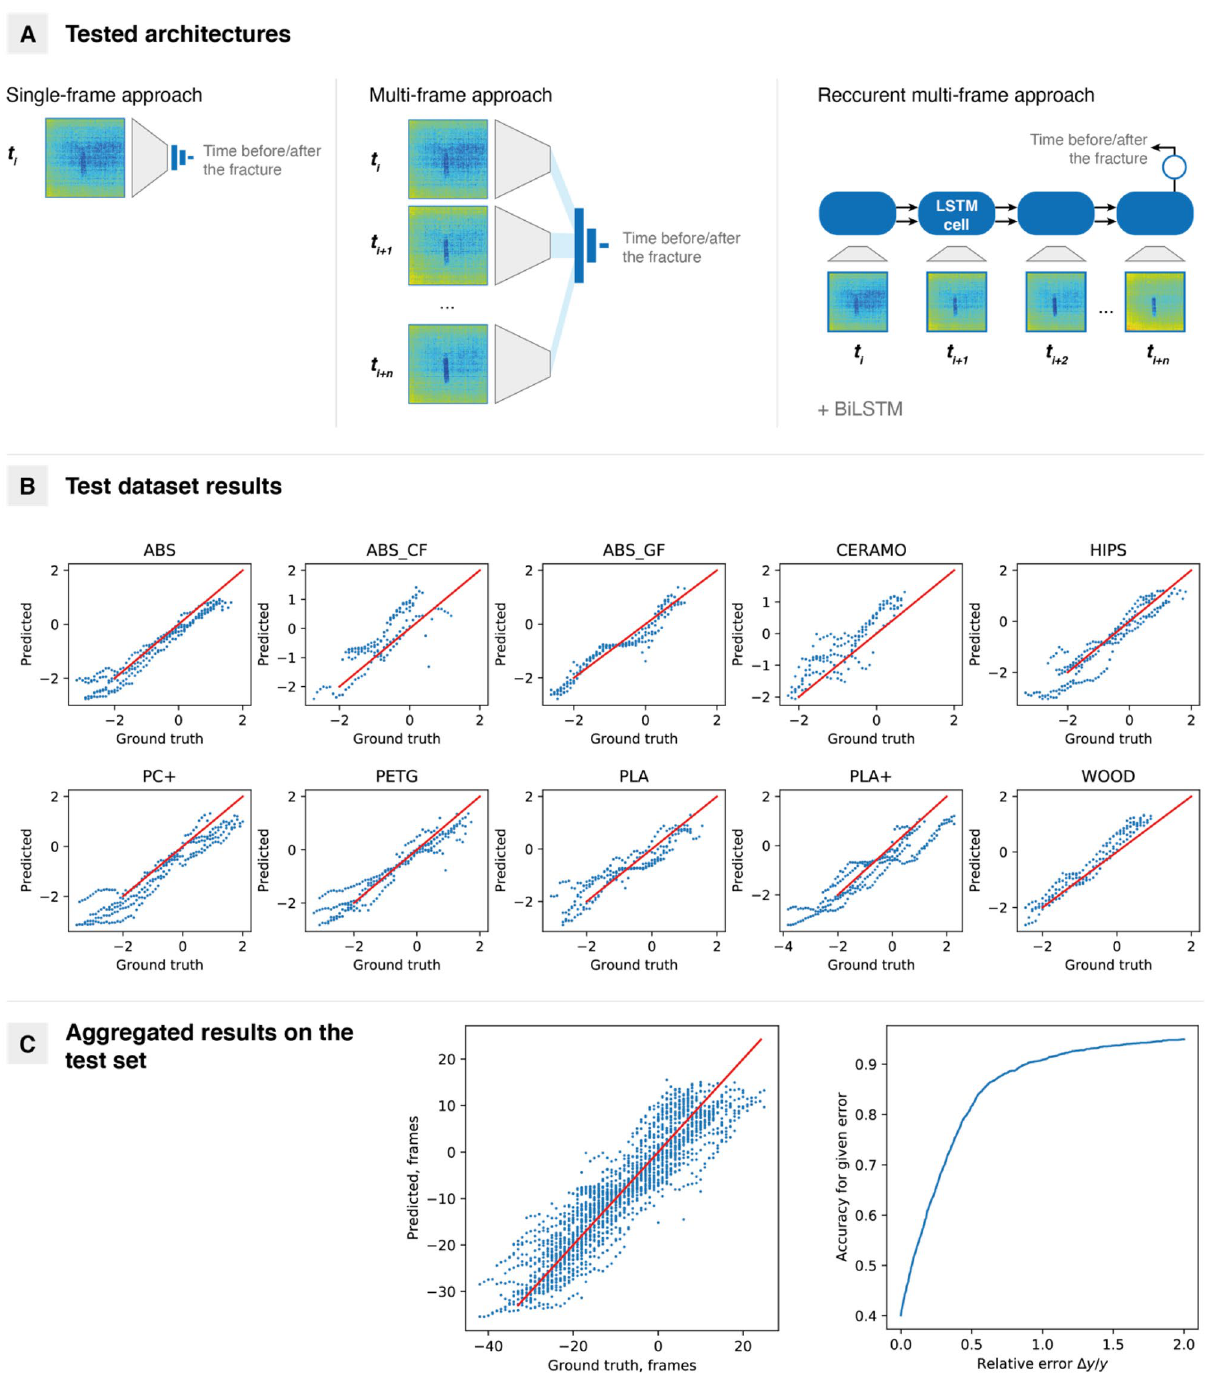
Figure 5. Neural network analysis of thermographic images. ( A ) Comparison of architectures; ( B ) Results for the best model by material; ( C ) Aggregated results on the test set for the best model. Model—bidirectional LSTM model with an embedding size of 256 elements. Ten consecutive frames were used for prediction. The hidden size is equal to 256. Each batch contained 200